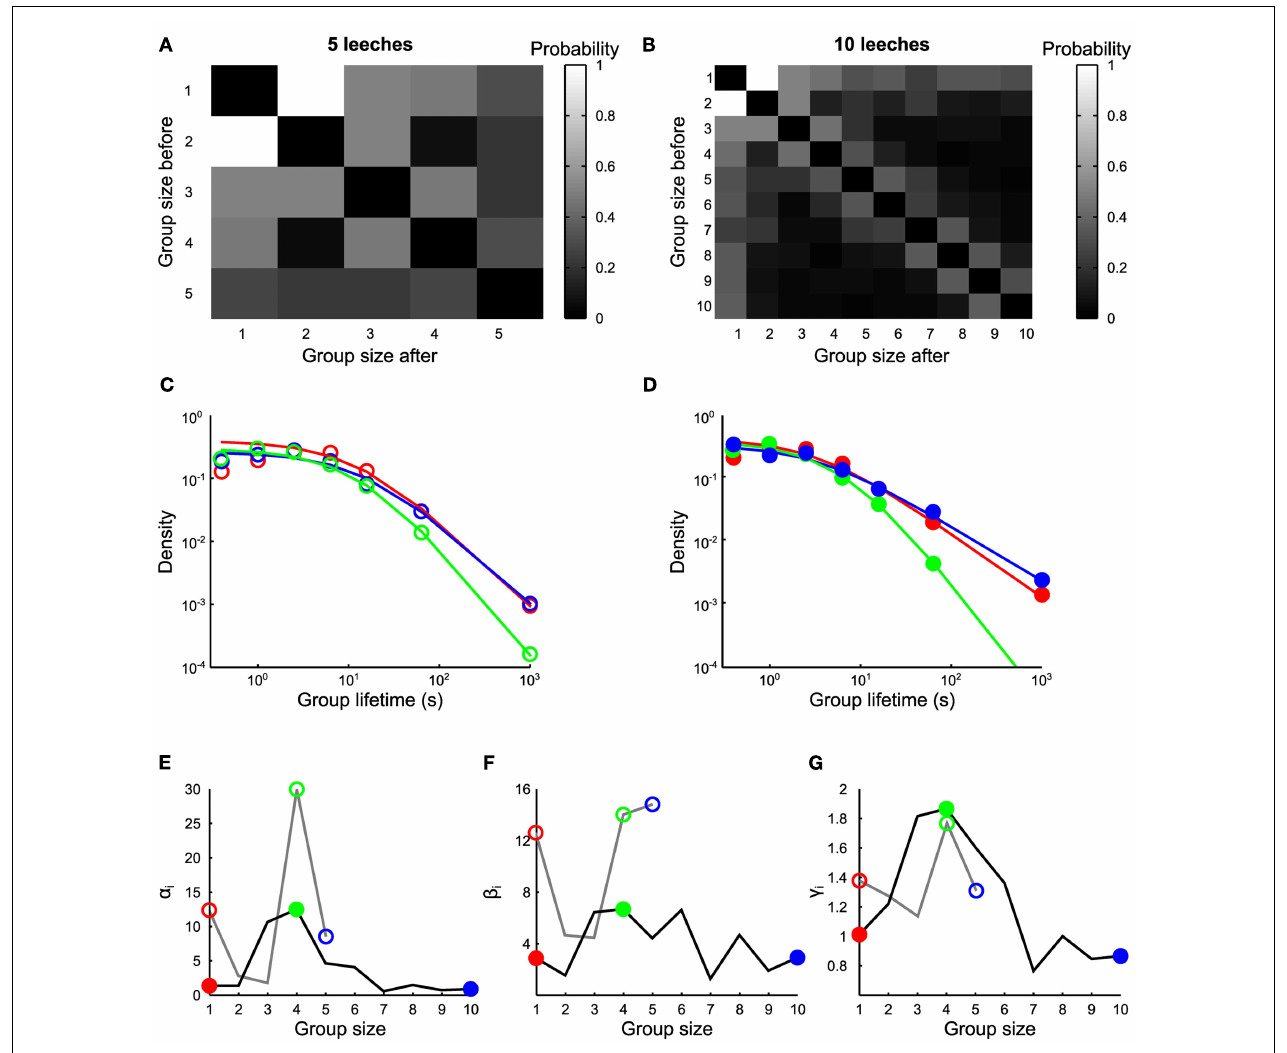
of 1 (red filled circles), 4 (green filled circles), and 10 (blue filled circles) leeches, and associated fit (continuous lines) with Eq. 1 for experiments with 10 leeches. (E–G) Values of α n , β n , and γ n as a function of n , with 5 leeches (gray continuous lines) and 10 leeches (black continuous lines). Empty and filled colored circles highlight the parameter values of fits reported in (C,D)